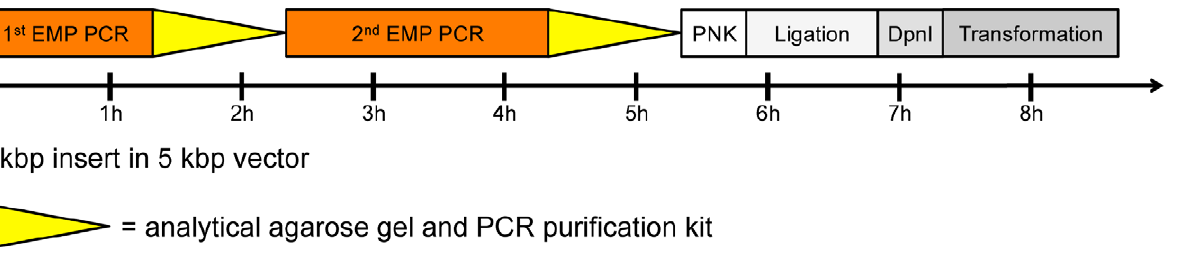
Figure 3. Time scale of a complete EMP cloning experiment. The time scale of a typical EMP cloning experiment with a 1 kb insert and a 5 kb template vector is shown. Boxes indicate separate subroutines of the experiment. Triangles indicate a PCR product analysis and purification step.